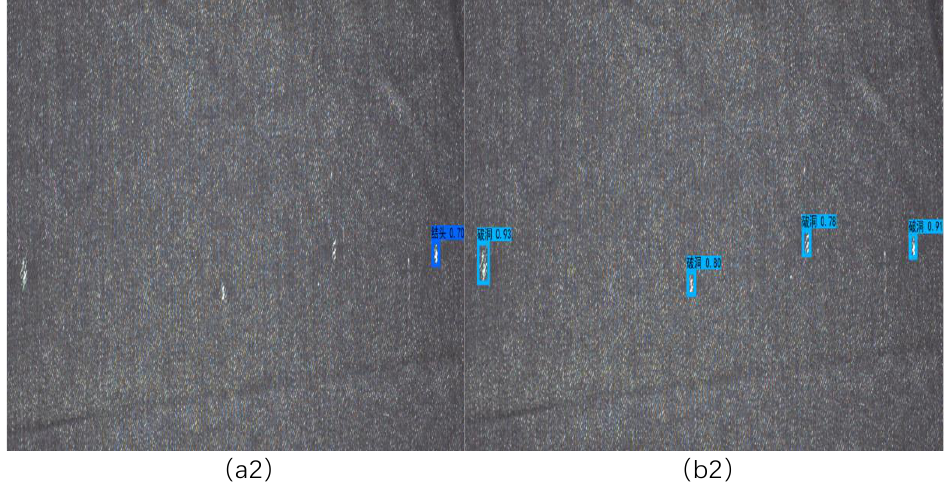
Figure 11. Experimental results of group2. ( a2 ) detection result of YOLOv4; ( b2 ) detection result of improved YOLOv4. Defect sizes are about 4 × 12 pixels.